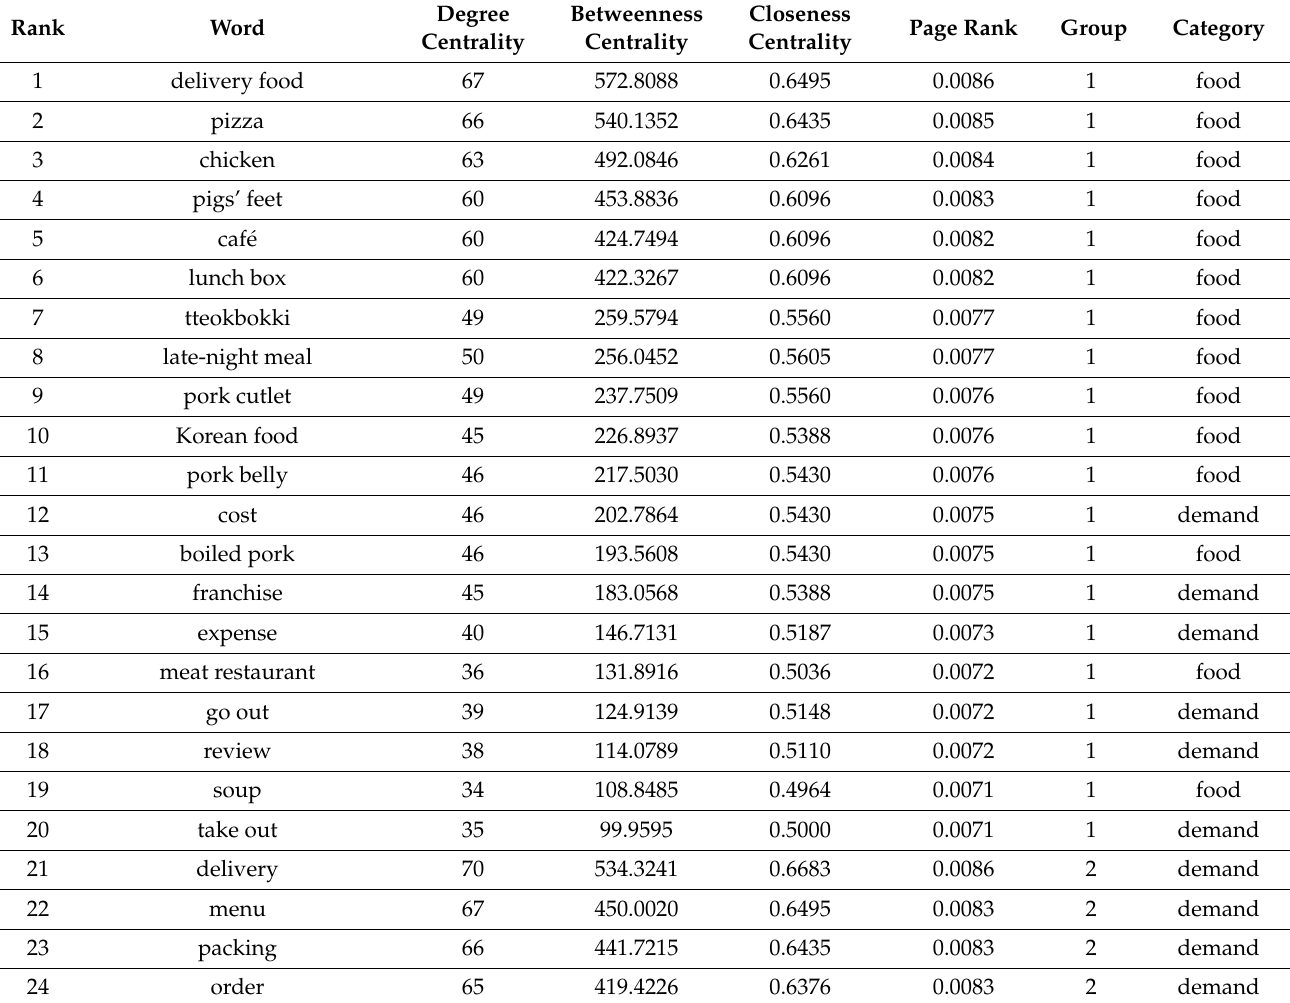
Table 7. Demand network index of food delivery